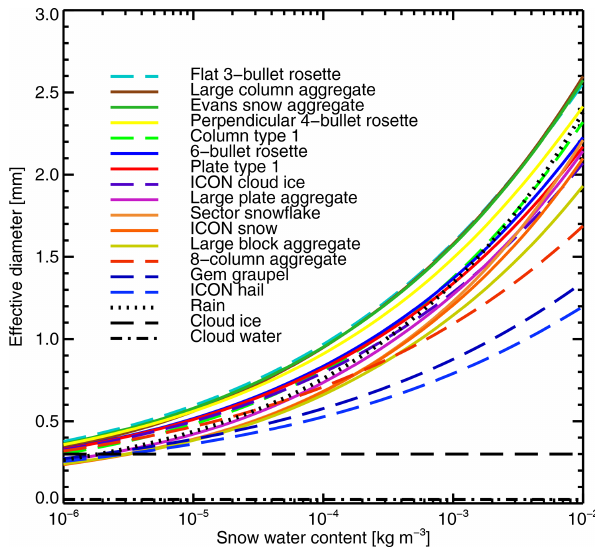
Figure B1. Effective diameter D eff resulting from the combination of ARTS frozen particles and the F07 T PSD, using all the same settings as Fig. 2. Also shown are the effective diameters of the standard rain, cloud water, and cloud ice configurations from Ta- ble 1 and Fig. 1. In the key, the ARTS particles (all coloured lines) are ordered by their effective diameter at the snow water content l = 1 × 10 − 3 kgm − 3